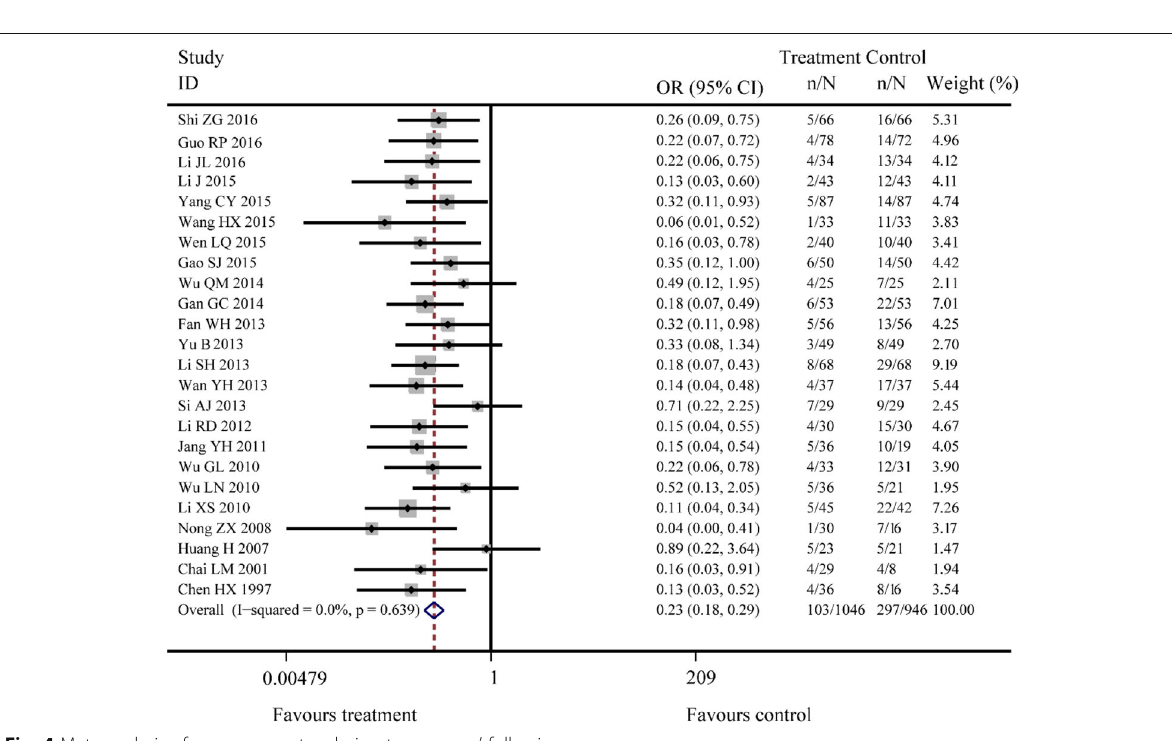
Fig. 4 Meta-analysis of recurrence rates during two groups ’